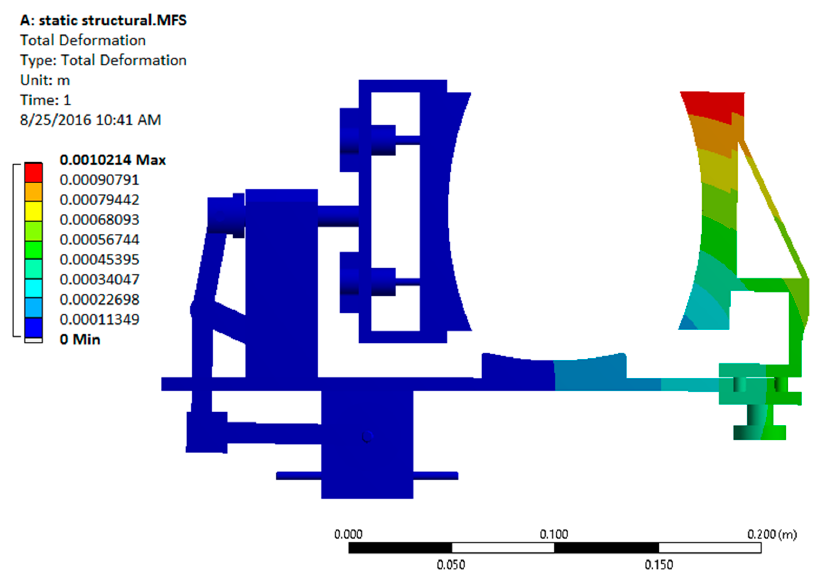
Figure 9. Total deformation plot of the device under the static loading conditions.